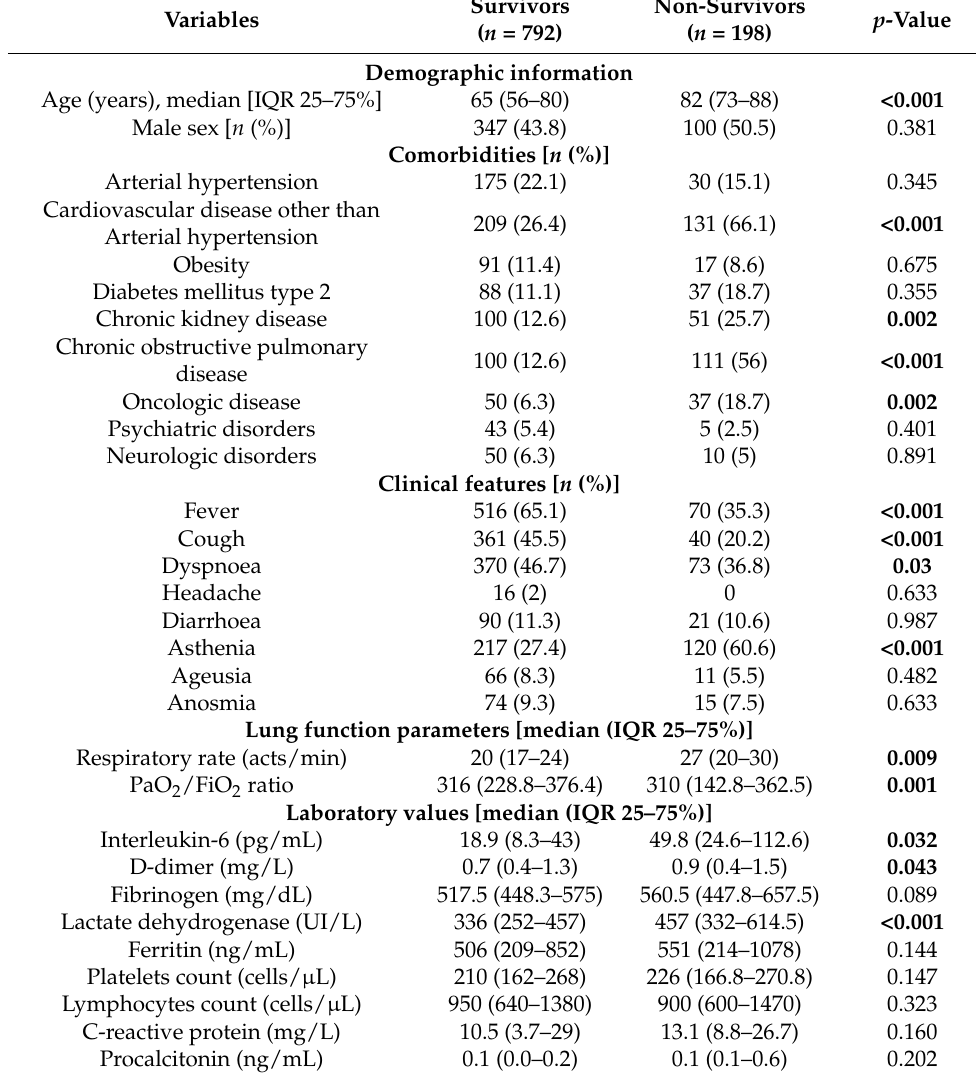
Table 4. Comparison between surviving and non-surviving COVID-19